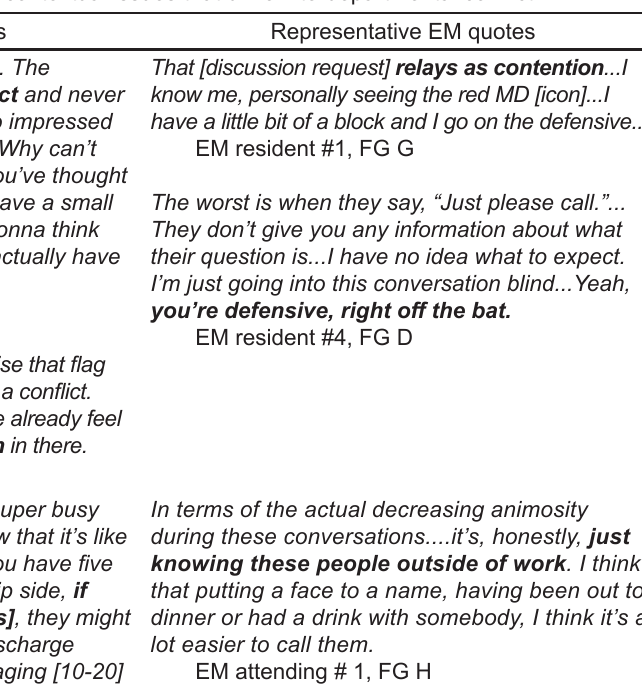
Table 3. Internal medicine and emergency medicine perspectives on contextual issues that drive interdepartmental conflict.*